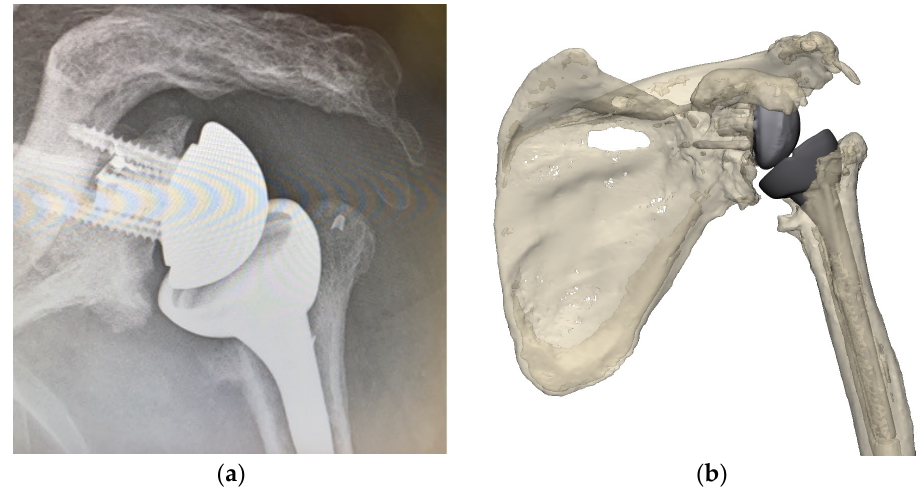
Figure 1. Preoperative X-ray of glenohumeral joint ( a ) and 3D reconstruction showing malpositioning of primary implants in situ (image from Reflect COMPLEX TM (Akunah, Brisbane, Australia)) ( b ).